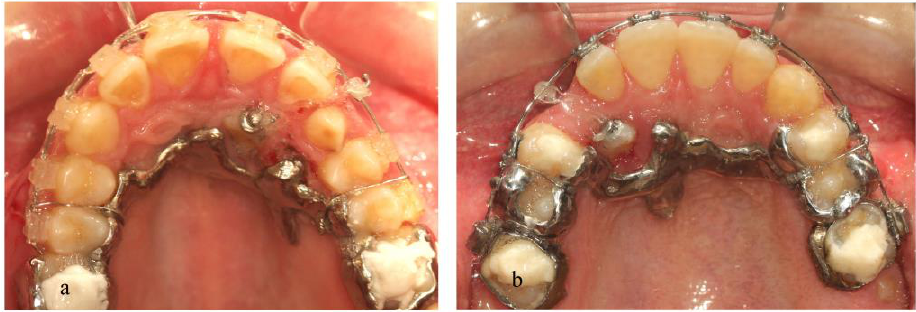
Figure 8. After 3 months, the canine’s crown appeared in the palate (( a ): patient 1, ( b ): patient 2). After removal of the chain apparatus, an orthodontic button was attached to the direction (Figure 9).